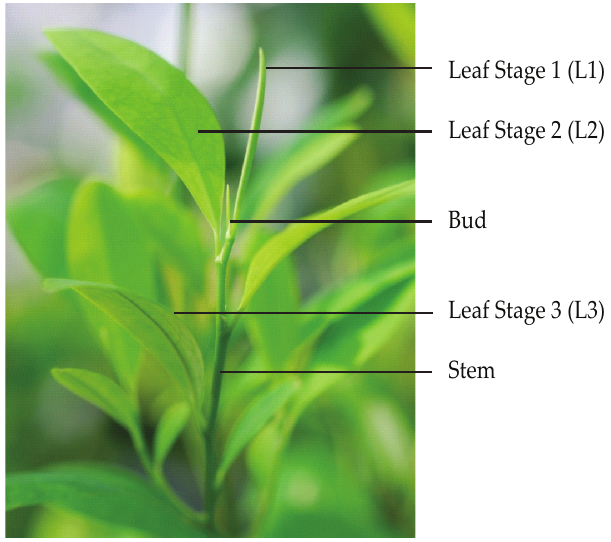
Figure 1. Developmental leaf stages of Erythroxylum coca plant . Leaf Stage I (L1) young rolled leaves, Leaf Stage II (L2) young expanded leaves, Leaf Stage III (L3) fully mature